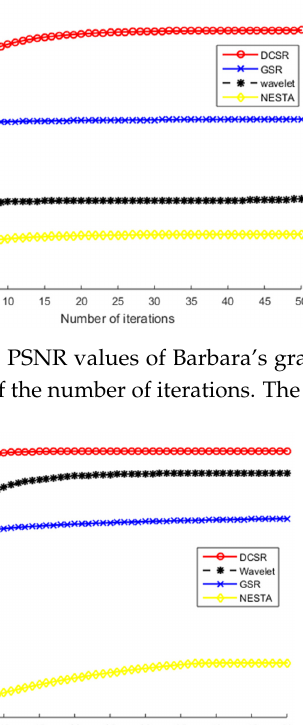
Figure 12. PSNR values of the Cameraman grayscale image recovered by four competing methods as a function of the number of iterations. The test image is corrupted by salt and pepper noise.